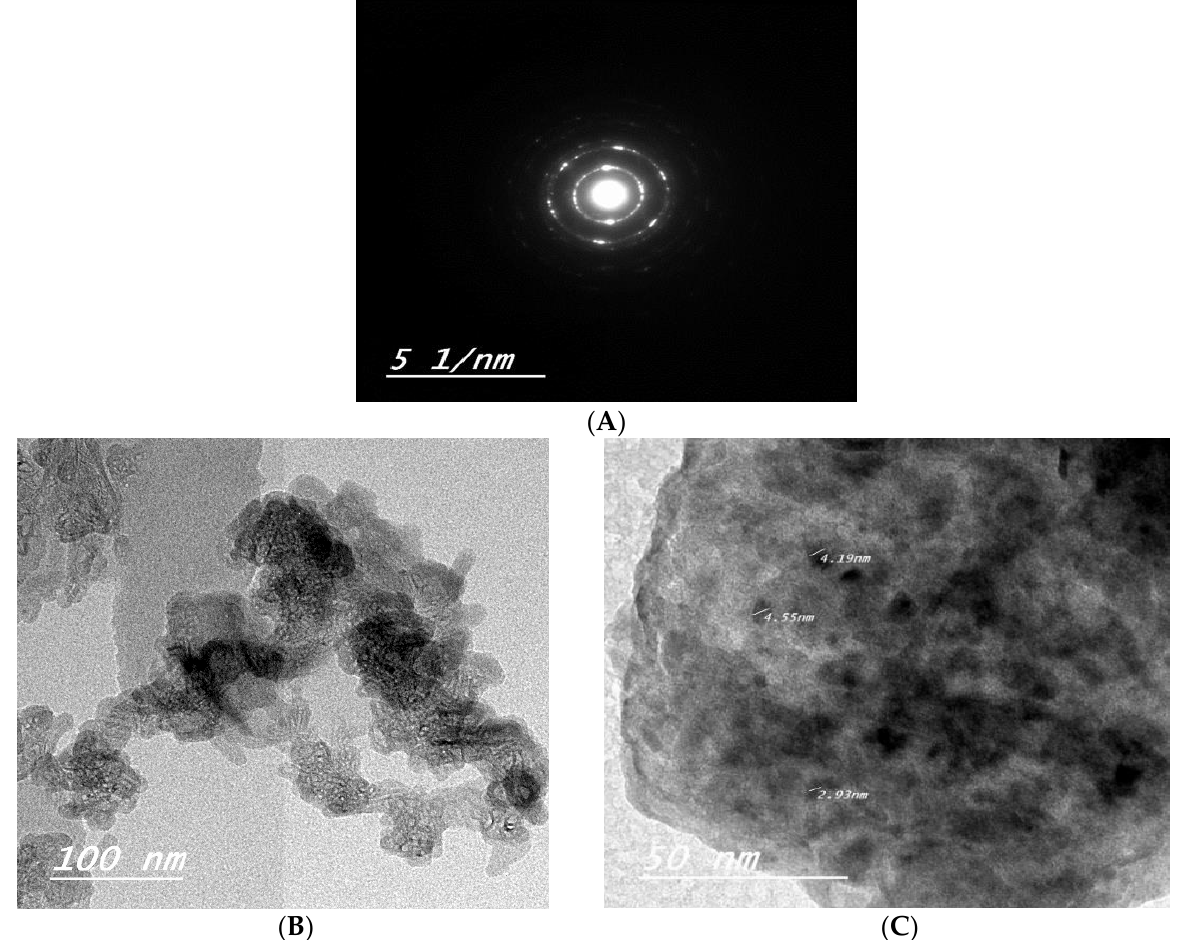
Figure 3. Selected area electron diffraction of Calcium Phosphate Nanoparticles ( A ),High Resolution Transmission electron micrographs at two different magnifications of Calcium Phosphate Nanoparticles ( B , C ).